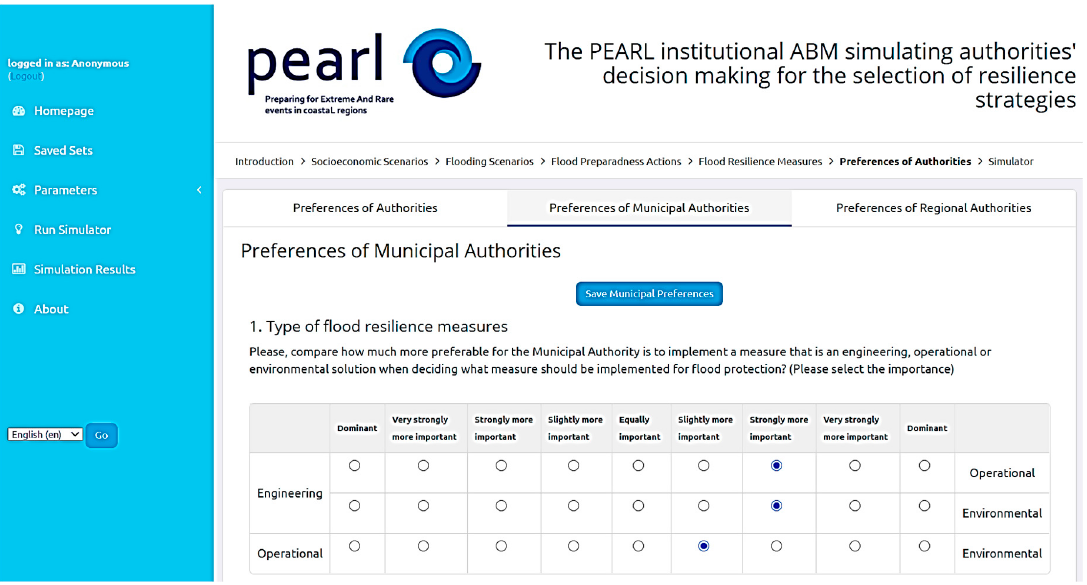
Figure 10. Preferences of authorities.